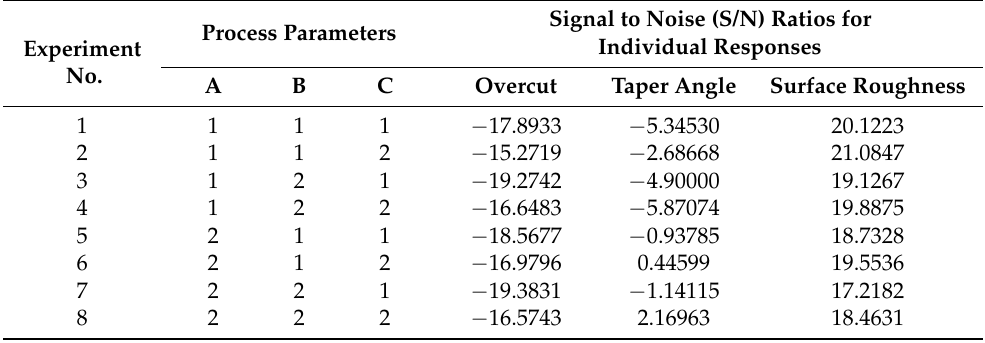
Table 5. Signal to Noise (S/N) ratios for the lower-the-better characteristics of all three responses. Process Parameters Signal to Noise (S/N) Ratios for Individual Responses Experiment No. A B C Overcut Taper Angle Surface Roughness